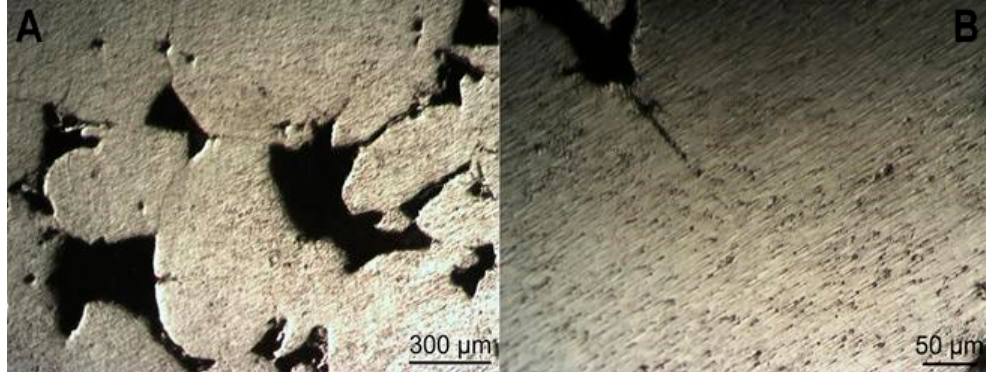
Figure 3. Optical micrographs of the Al/MoB 2 nanocomposite pellets: ( A ) at low magnification; ( B ) at higher magnification.